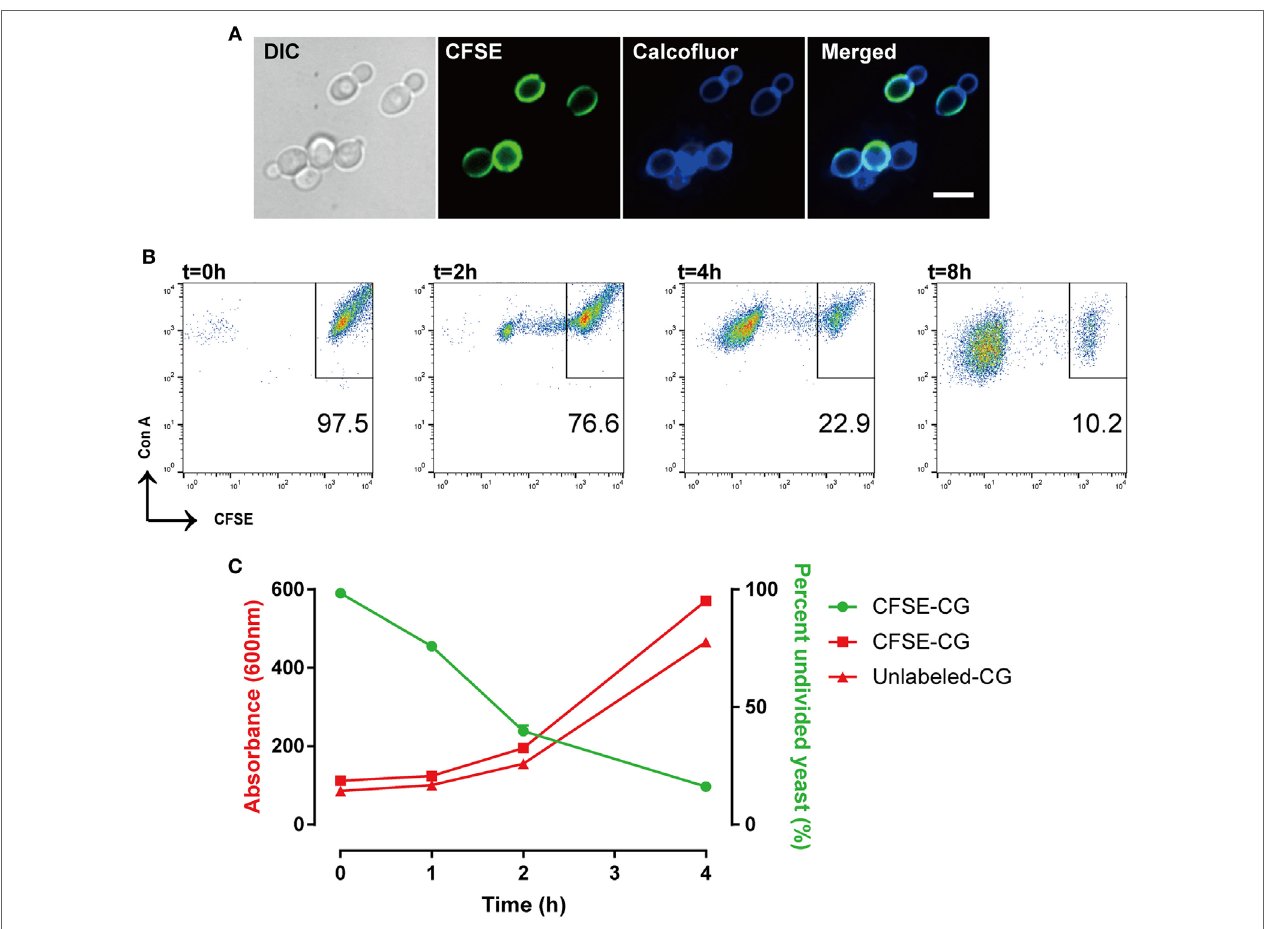
FigUre 2 | Carboxyfluorescein succinimidyl ester (CFSE)-labeling marks Candida glabrata yeast division. (a) Differential interference contrast and fluorescence microscopy image of CFSE-labeled C. glabrata that have undergone division and stained with calcofluor white. Parental cells exhibit full CFSE labeling,